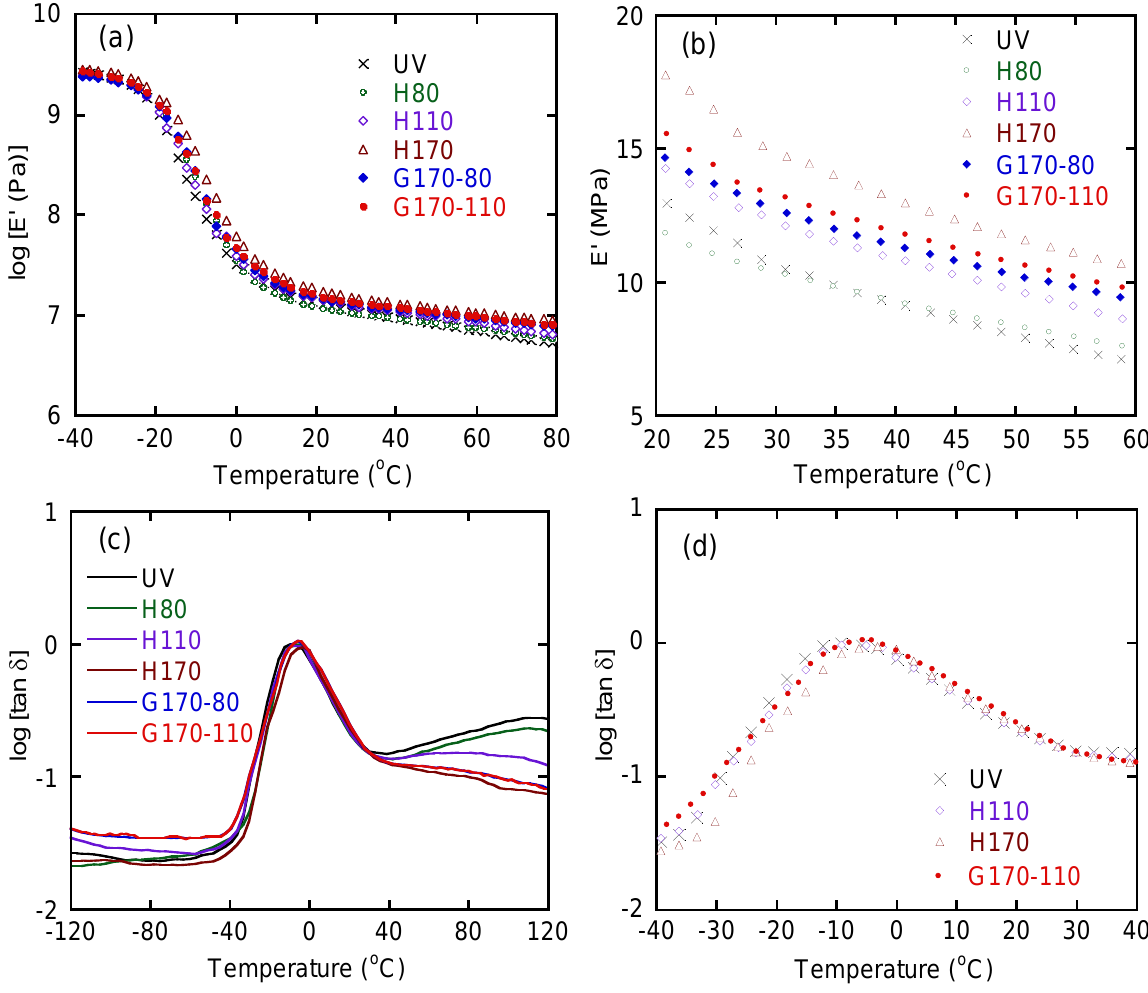
Figure 2. Temperature dependence of ( a ) and ( b ) tensile storage modulus E’ and ( c ) and ( d ) loss tangent tan δ at 10 Hz.